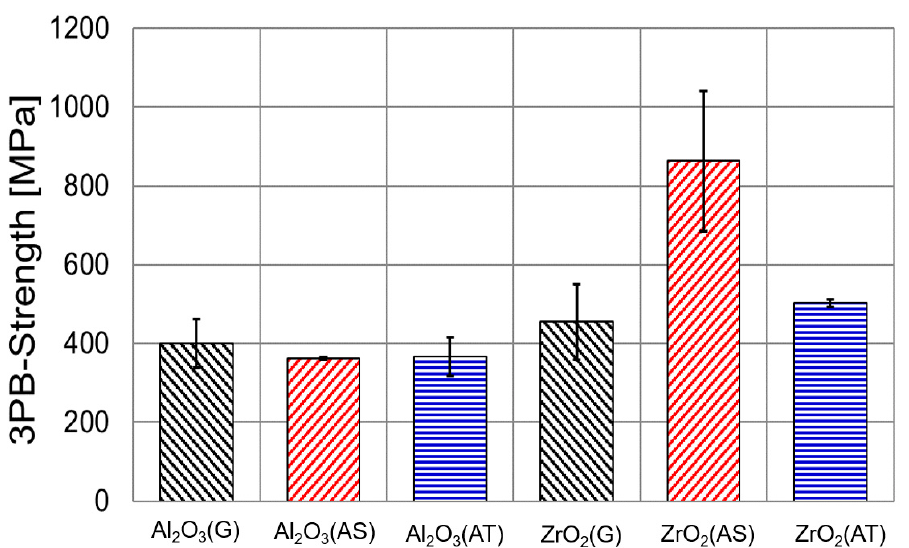
Figure 3. 3PB strength values of Al 2 O 3 and ZrO 2 in the unexposed state (G, black color), after exposure in the molten chloride salt (AS, red color) and after pure thermal treatment without molten chloride salt (AT, blue